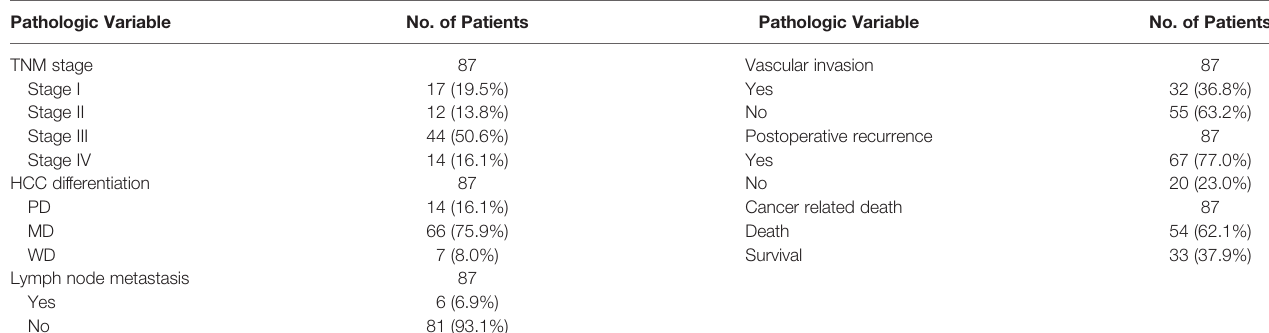
TABLE 1 | Clinicopathologic Parameters of Patients.